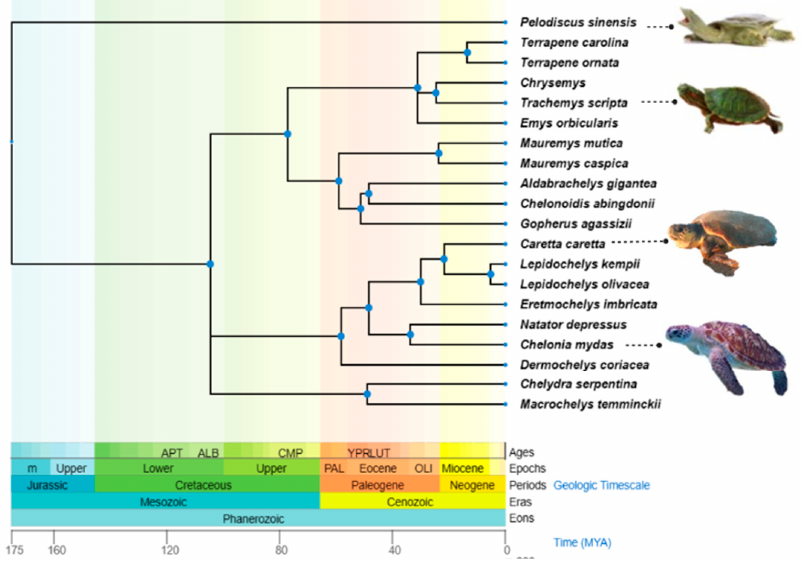
Figure 1. The phylogenetic tree of Testudines species is mentioned in this review. The tree was constructed from the information provided by http://timetree.org/ (accessed on 20 December 2022). The immune response of Testudines (turtles, terrapins, and tortoises) is the most studied of the surviving lineages in class Reptilia, which includes Crocodilia (crocodilians), Squamata (snakes, lizards, amphisbaenians) and Rhychocephalia (tuatara) [65]. Yet, these studies represent only 12% of the 365 species of Testudines [65]. Studies have focused on turtles’ heavy reliance upon the robust innate response to pathogens, leaving questions regarding the role of the adaptive response. The anti-viral response, in particu- lar, is poorly understood [19,66,67]. Turtles’ lymphocytes are believed to respond to infec- tion in a relatively nonspecific way with an altered antibody and memory response [66]. Large gaps in knowledge of the sea turtle immune system include; the mechanism of path- ogen recognition through pattern recognition receptors (PRRs), the pathways and effi- ciency of antiviral effectors such as interferons (IFNs) and IFN-stimulated genes (ISGs), the role of cytotoxic T cells in killing infected or damaged host cells, and the mechanism and locations of T cell-mediated B cell activation [66]. Understanding these gaps will not only elucidate the evolution and diversity of the immune system but will also assist in the conservation of vulnerable sea turtle species from threats of chronic disease, infection, and a degrading marine environment. For ex- ample, fibropapillomatosis (FP) is a tumorous disease that affects sea turtles. The dramatic increase in FP prevalence since the 1980s is attributed to a virus, and an unknown